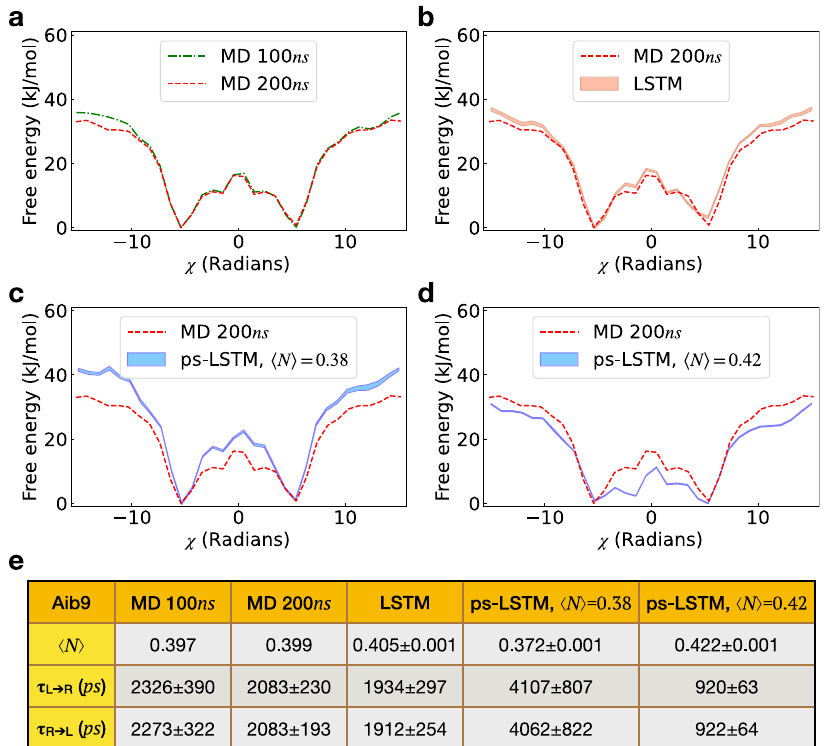
Fig. 4 | Comparing predictions at 200 ns for different values of the dynamical constraint 〈 N 〉 . Inthisplot,weshowthefreeenergypro fi lescalculatedfrom( a )the 100 ns trajectory in the training set, ( b ) both the actual 200 ns trajectory and direct prediction from LSTM, ( c ) the reference 200 ns trajectory and ps-LSTM prediction with constraint of nearest-neighbor (NN) transitions 〈 N 〉 =0.38, and ( d ) the refer- ence200 ns trajectoryandpredictionwithconstraint 〈 N 〉 =0.42.Thetablein( e )lists thekineticconstraint 〈 N 〉 calculatedfromcorrespondingtrajectories.Theaveraged transition time τ R → L and τ L → R in picoseconds were calculated by counting the